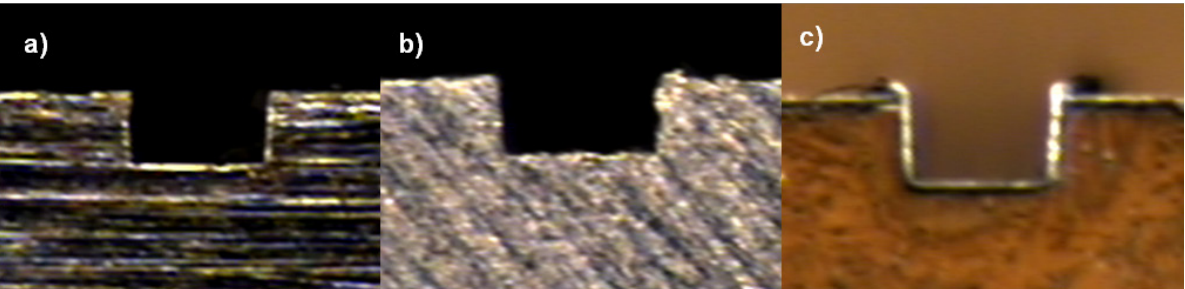
Al V; ( b ) AISI 316L and ( c ) Aluminum alloy. 6 4